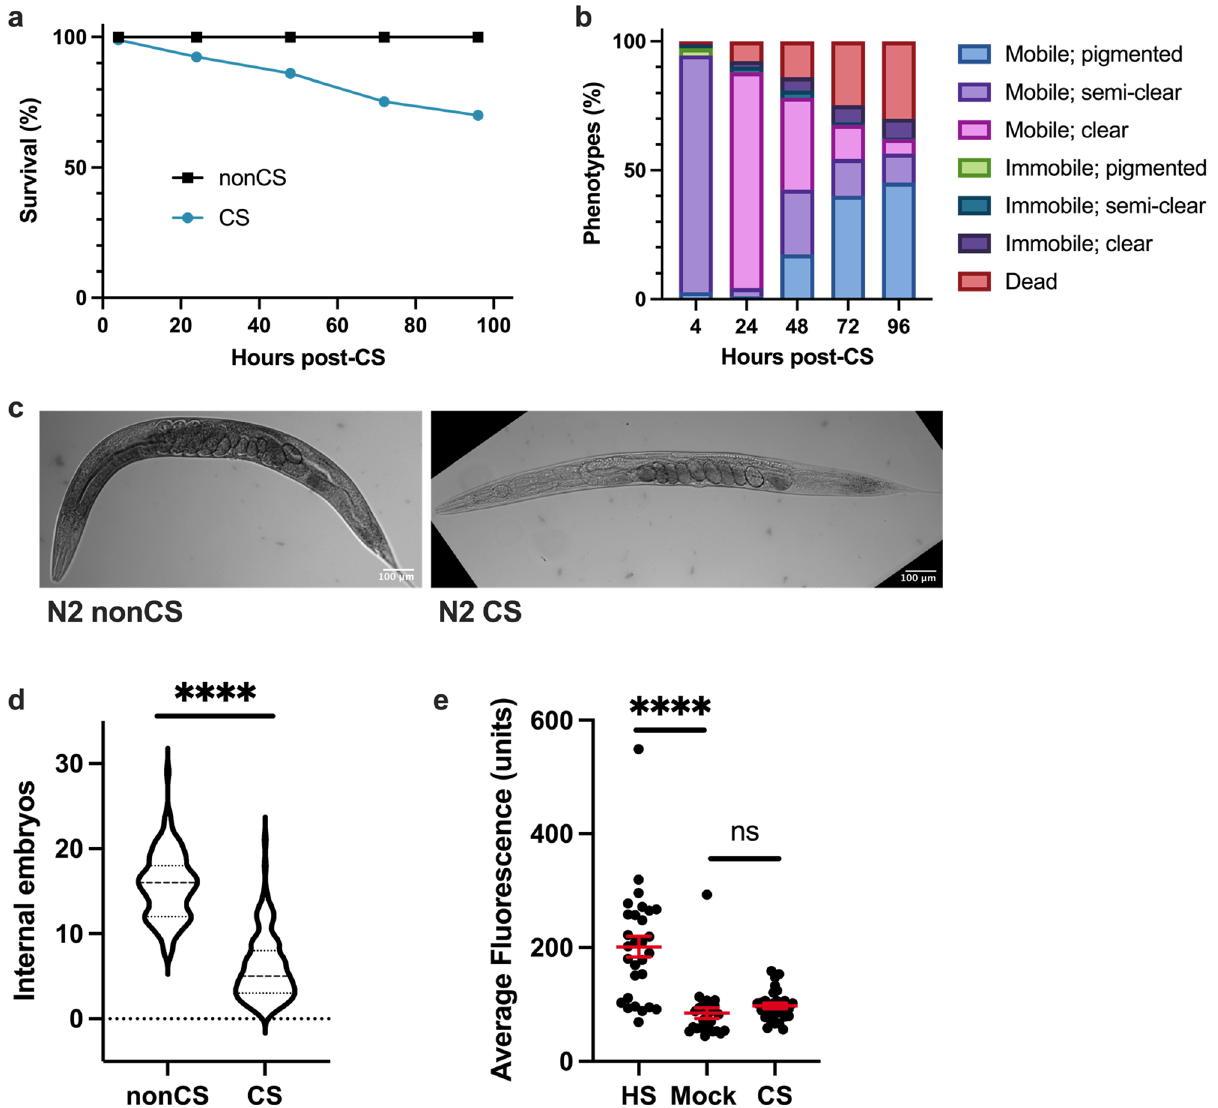
Figure 1. Cold-shocked worms show decrease in survival and characteristic phenotypic alterations. N2 young adult hermaphrodites were shifted from 20 to 2 °C for a 4 h cold shock (CS) and thereafter recovered at 20 °C for 96 h with assessment of ( a ) survival and ( b ) phenotypic alterations (n = 177). Death and immobility were assayed by nose tap; worms were considered to be immobile if the tap elicited slight movement in the head region but no other body movement, and dead worms were completely unresponsive (Chi-squared Test for Homogeneity: P < 0.0001 at 24 h). ( c ) Representative images of young adult N2 hermaphrodites following cold shock. ( d ) Average number of internal embryos per worm in CS versus nonCS conditions (Mann–Whitney U test: U = 604, two-tailed P < 0.0001). ( e ) Induction of heat shock protein HSP-4::GFP 12 h after either 2 h heat shock at 35 °C, 4 h cold shock at 2 °C, or no treatment (n ≥ 26 per condition; Kruskal–Wallis test: H = 33.86, P < 0.0001; Dunn’s Multiple Comparison Test: **** P < 0.0001). Error bars are mean ±